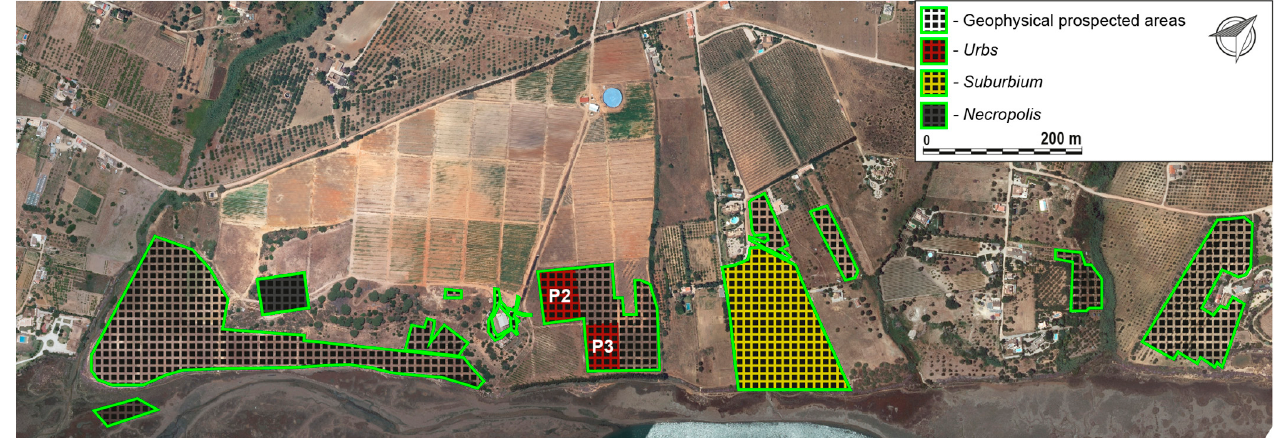
Figure 2. Total areas subjected to GPR geophysical surveys in the city of Balsa and plots analysed in this paper.